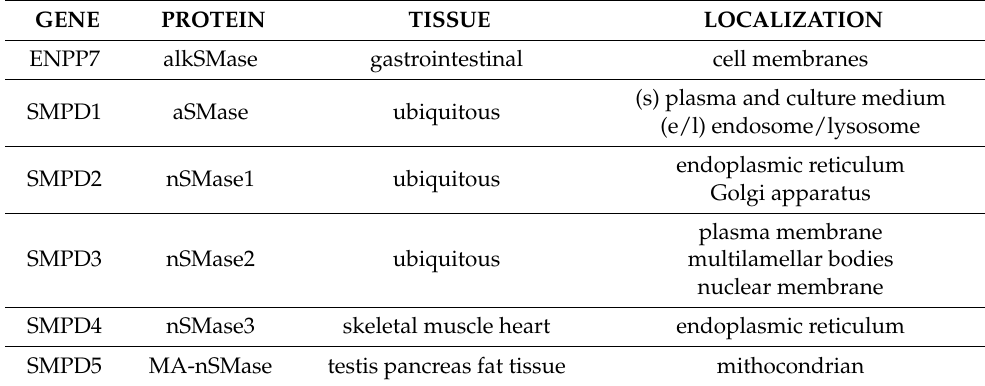
Table 1. Genes encoding for sphingomyelinases. ENPP7 , ectonucleotide pyrophosphatase/ phos- phodiesterase; SMPD, sphingomyelin phosphodiesterase; alkSMase, alkaline sphingomyelinase; aSMase (s), secretory sphingomyelinase; aSMase (e/l), sphingomyelinase associated with the endo- somal/lysosomal compartment; nSMase, neutral sphingomyelinase; MA-nSMase, mitochondrial- associated neutral